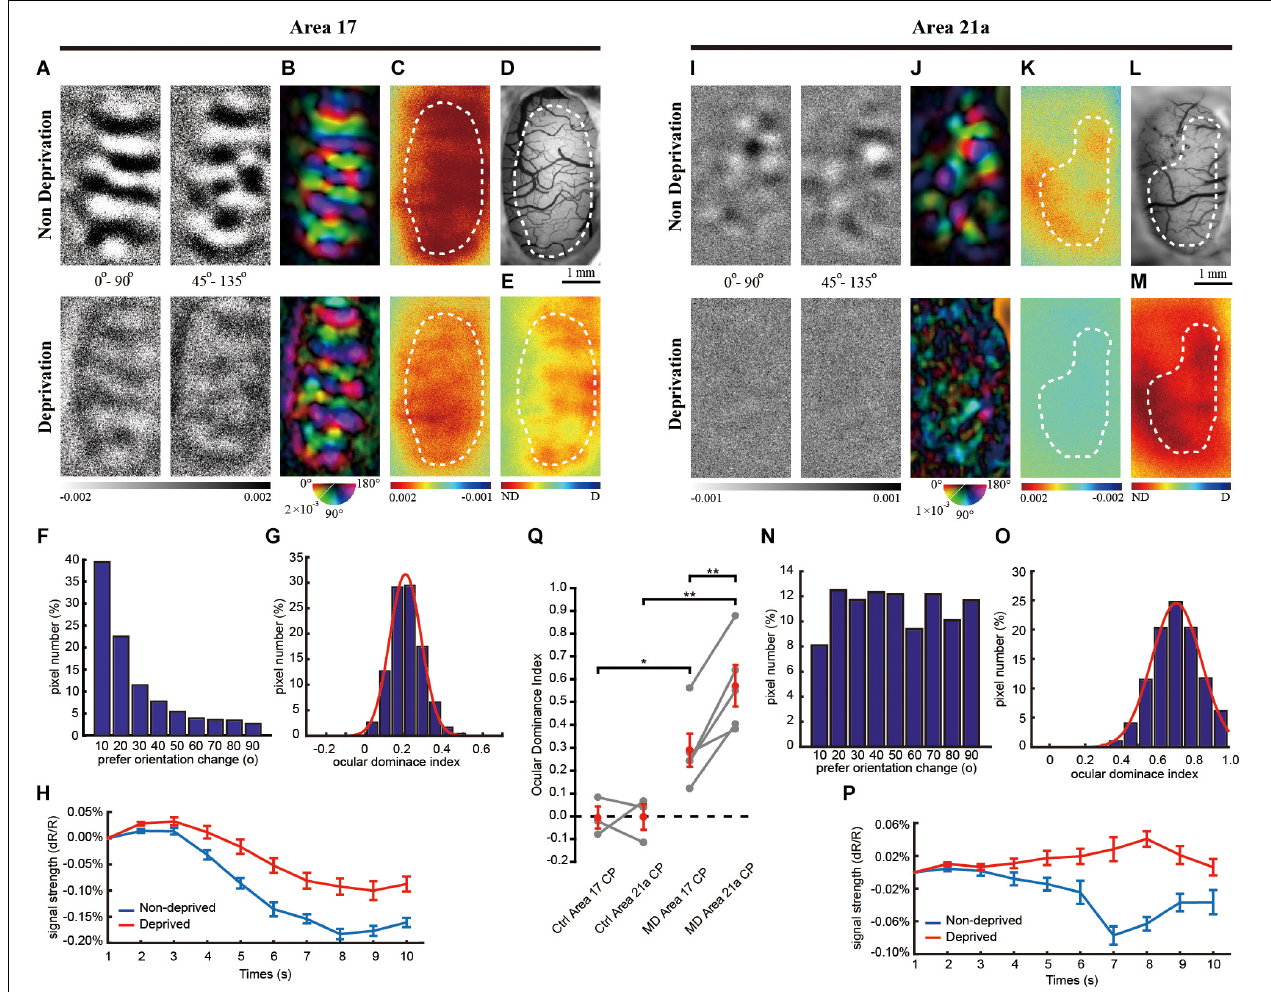
FIGURE 2 | The same-animal comparison between OD maps in areas 17 (A – H) and 21a (I – P) in kittens monocularly deprived for 3 days ( A – P are from one typical cat, and Q illustrates data pairs of area 17 and area 21 from multiple animals). (A,I) Each row shows orientation differential maps evoked by monocular stimuli. Top: non-deprived eye. Bottom: deprived eye. Each column shows orientation differential maps with varying-orientation stimuli. Left: 0–90 ◦ . Right: 45–135 ◦ . (B,J) Orientation tuning is visualized by orientation polar maps, in which different colors represent the preferred stimulus orientation, and the gray scale represents the tuning strength of each pixel. Top: non-deprived eye. Bottom: deprived eye. (C,K) Global signal maps showing the averaged cortical response to stimuli with all orientations. Top: non-deprived eye. Bottom: deprived eye. (D,L) Blood vessel map. Scale bars: 1 mm. (E,M) OD maps of area 17 and area 21a. Red regions of the OD map represent domains dominated by non-deprived eyes, and blue regions represent domains dominated by deprived eyes. (F,N) The distribution of pixelwise differences of preferred orientation between the two eyes. (G,O) The distribution of the ODI of pixels in the dashed regions in (E,M) , respectively. (H,P) The time course of the global signals in area 17 and area 21a for the two eyes. Each global signal represents the mean of all the pixels in the ROI (shown as dotted region in C or K ). (Q) Statistical analysis of the OD shift in kittens. The mean ODI of all the pixels in the ROI was calculated as the ODI of this cortical area and shown as one individual point. N = 3 kittens for the control group and n = 5 kittens for the MD group. Note that area 17 and area 21a were imaged from the same animal, and the data points from the same animal are connected with lines. Data are means ± SEM; paired-sample and two-sample t -tests: ∗ p < 0.05, ∗∗ p <